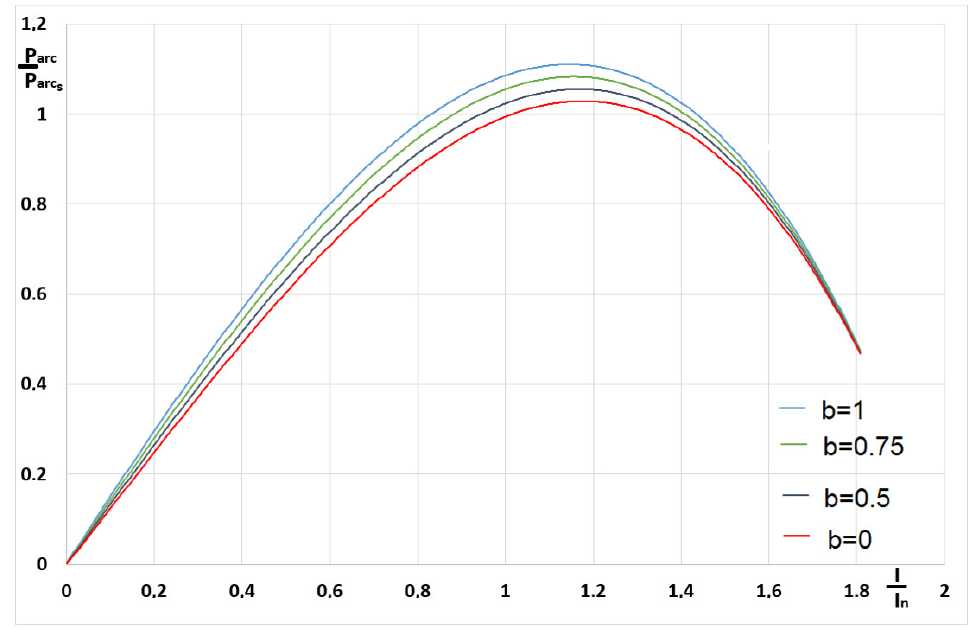
Figure 28. Arc force as a function of the arc current for different values of the parameter b .